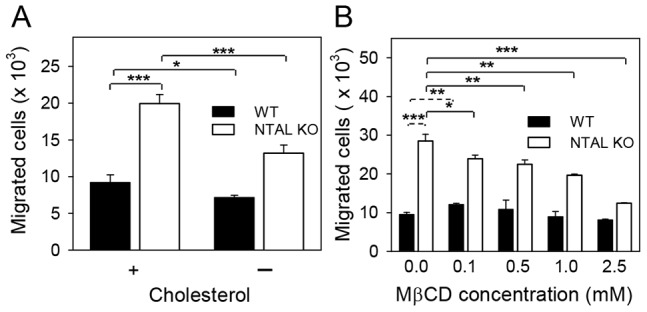
Different sensitivity of Ag-mediated chemotactic response of WT and NTAL KO BMMCs to cholesterol depletion.(A) BMMCs were cultured in media supplemented with IL-3 (without SCF) and 10% FCS with (+) or without (-) cholesterol. After 52 hours the cells were washed, suspended in medium with 10% FCS or cholesterol-depleted FCS and sensitized with TNP-specific IgE (1 µg/ml). After 14 hours, the cells were washed in chemotaxis medium and transferred into Transwell inserts, which were then immersed into the wells of the Transwell system with 600 µl of chemoattractant (250 ng/ml TNP-BSA) in chemotaxis medium. The number of cells passing through the filter was counted 8 hours later with flow cytometer. (B) The cells were cultured in medium supplemented with 10% FCS and IL-3 for 52 hours and then sensitized with TNP-specific IgE (1 µg/ml). After 14 hours, the cells were washed in chemotaxis medium containing various concentrations of MβCD and incubated at 37°C. After 30 min, the cells were washed in chemotaxis medium and transferred into Transwell inserts, which were then immersed into the wells of the Transwell system with 600 µl of chemoattractant (250 ng/ml TNP-BSA) in chemotaxis medium. The number of cells passing through the filter was counted 8 hours later with flow cytometer. Means and SD were calculated from data obtained in 3–4 independent experiments performed in duplicates. *p<0.05; **p<0.01; ***p<0.001.